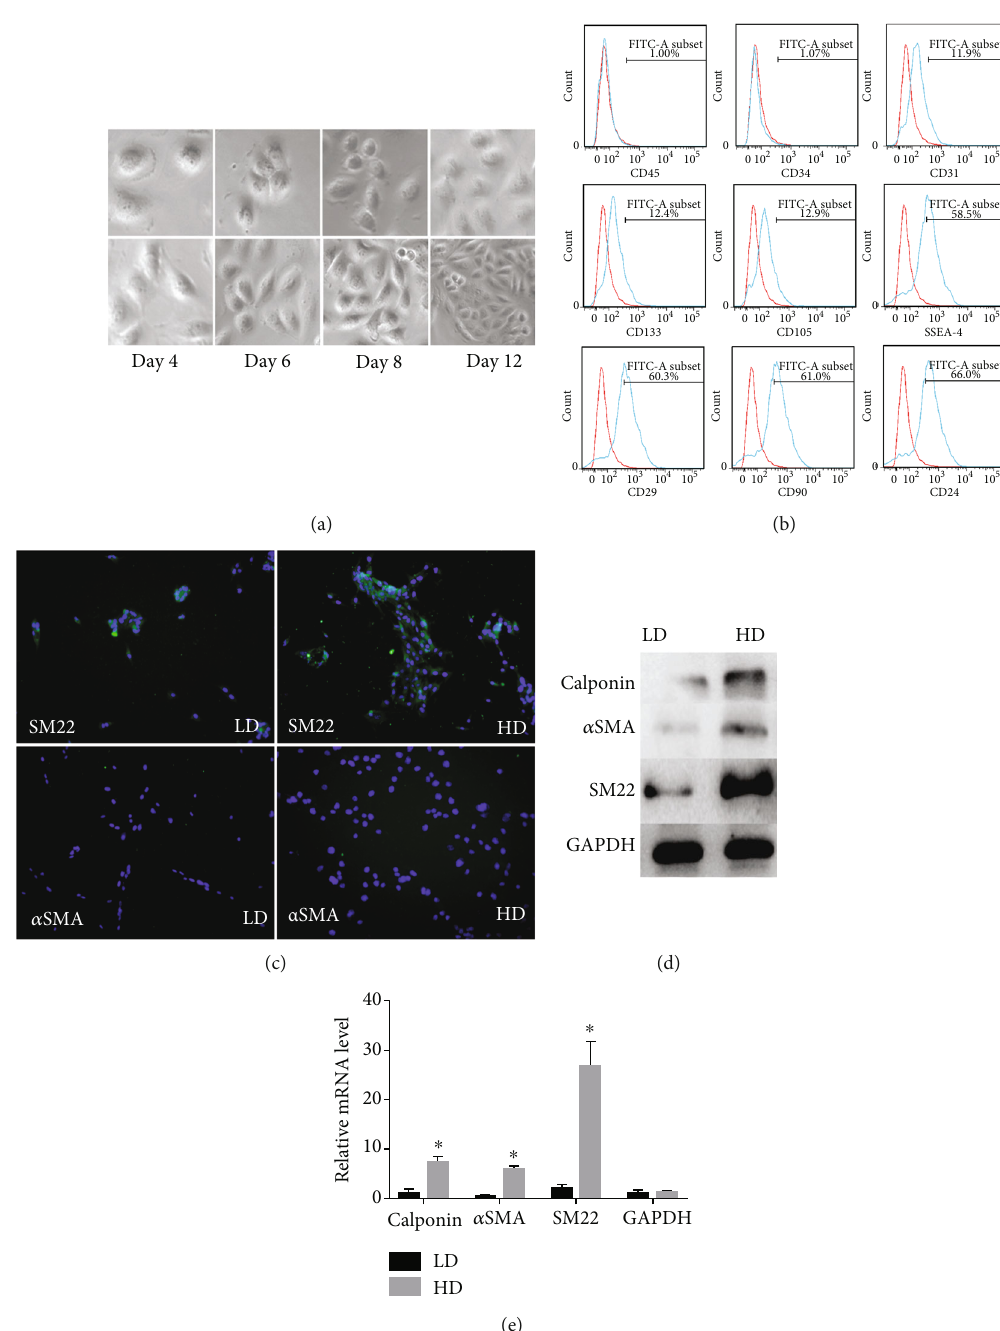
Figure 1: (a – e) USCs isolated from urine of dogs and high cell density promoted USCs di ff erentiation into SMCs. Representative images of dog USCs expansion on days 4, 6, 8, and 12 at low density (LD) or high density (HD) (a). Flow cytometric analysis reveals CD surface antigen expression on dog USCs; pluripotent stem cell markers (SSEA-4, CD29, CD90, CD24) were strongly positive; CD31, CD133, and CD105 were weakly positive; hematopoietic cell marker CD45 and endothelial lineage markers CD31 and CD34 were negative (b). USCs were seeded at low density (LD) or high density (HD), immunostaining for SM22 and aSMA. Nuclei were counterstained with DAPI (blue) (c). Western blot and qRT-PCR for calponin, aSMA, and SM22 were quanti fi ed to show relative protein and mRNA levels in LD and HD USCs, respectively (c, with PBS, samples were conjugated with secondary antibody serum, 0.01% ( v / v ) Triton X-100 in PBS), samples were incu- (ab150077, Abcam, 1 : 500; or ab150113, Abcam, 1 : 500), bated overnight at 4 ° C with the primary antibodies: ILK followed by staining with DAPI (25 mg/ml in TNE bu ff er: (ab76468, Abcam, 1 : 200), Desmin (ab32362, Abcam, 1 : 100), and SMN (ab5831, Abcam, 1 : 100). After washing